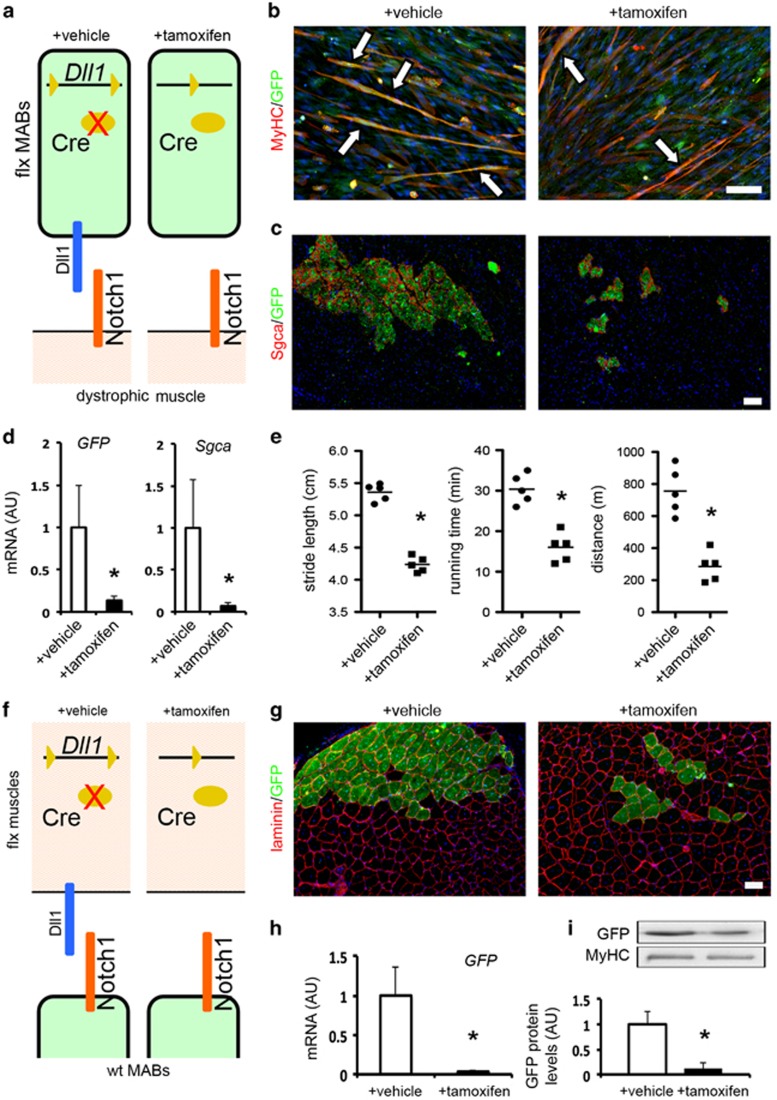
Analysis of Dll1 requirement for MAB engraftment/regenerative capacity using Dll1flx/flx;Rosa26::iCreERT2+/− (flx) transgenic MABs and muscles. (a) Representative scheme of the experiment assessing tamoxifen-driven Dll1 knockout in the homing flx MABs, using the vehicle-treated cells as control. (b) Immunofluorescence staining on co-cultures of C2C12 myoblasts with GFP+ flx MABs after Dll1 knockout. White arrows indicate chimeric MyHC+ myotubes and MAB myogenic differentiation. (c) Immunofluorescence staining on gastrocnemius muscle slides to evaluate the regenerative capacity of Dll1-knockout GFP+ flx MABs at 8 weeks after intra-arterial injection into Sgca-null mice. (d) qPCR-based quantification of engraftment (GFP) and regeneration (Sgca) into the tibialis anterior muscles at 8 weeks post injection; *P<0.05 versus vehicle-treated flx MABs (n=5 mice/group). (e) Functional assessment of conditional Dll1 knockout on MAB-driven regeneration of dystrophic muscles at 8 weeks after bilateral injection, by means of gait analysis (stride length) and treadmill assay (running time, distance). Data points depict the value of each assayed mouse, bars indicate the average values; *P<0.05 versus vehicle-treated flx MABs (n=5 mice/group). (f) Representative scheme of the experiment assessing tamoxifen-driven Dll1 depletion in the flx muscles, using the vehicle-treated mice as control. (g) Immunofluorescence staining on gastrocnemius muscle slides to evaluate the engraftment ability of homing GFP+ MABs into Dll1-knockout muscles at 4 weeks after intra-arterial injection. (h, i) Expression and protein level analyses of GFP to quantify reduced homing ability of MABs into tibialis anterior fibers after conditional Dll1 knockout at 4 weeks post injection; *P>0.05 (n=3 mice/group). Expression and protein levels in (d, h, i) are reported in arbitrary units (AU) as fold change versus vehicle-treated mice. Scale bars indicate 100 μm